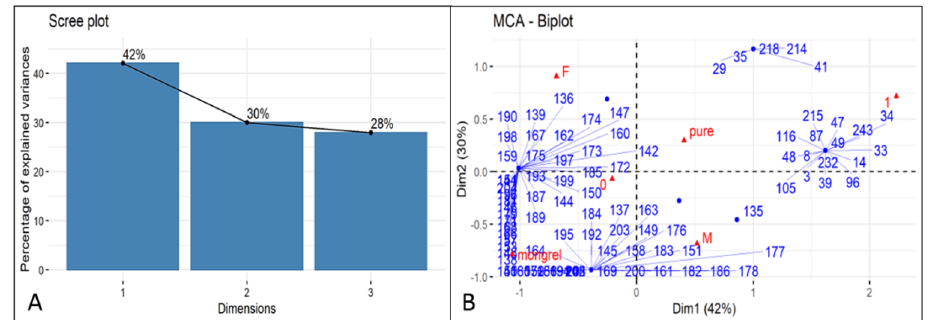
Figure A1. ( A ) Scree plot of the percentages of variance explained by each MCA dimensions (axes); ( B ) Biplot shows a global pattern within the data (individuals and variable categories): individuals are represented by blue points and variable categories by red triangles. 0 = Pneumocystis negative; 1 = Pneumocystis positive; pure = pure breed; mongrel= mixed breed; M = male; F = female. Number